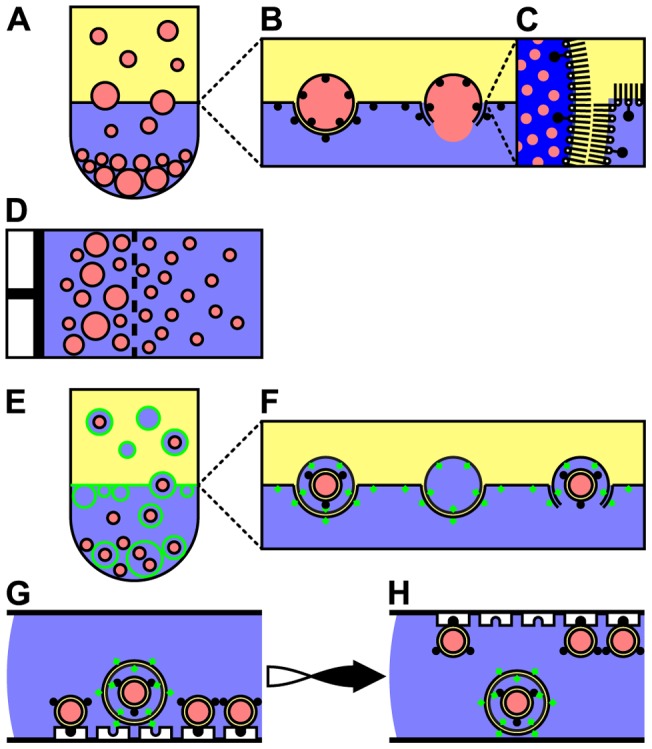
Schematic illustration of the preparation and isolation of intact hierarchical unilamellar vesicles (HUVs).A–C) Preparation of intermediate giant unilamellar vesicles (GUVs) employing the water-in-oil (w/o) emulsion transfer method. Black solid circles indicate biotinylated phospholipids. B, right) Imperfections in either of the two monolayers induce a release of the internal cargo into the hosting solution. C) When passing the water-oil interface the two phospholipid monolayers combine and form a bilayer confining the fluorescently active internal cargo (red circles). D) Repeated extrusion to homogenize the size distribution of the intermediate GUVs. E,F) Preparation of HUVs employing the vesicle-in-water-in-oil emulsion (v/w/o) transfer method. Green solid diamonds indicate fluorescently labeled phospholipids. G, H) Isolation of HUVs from released GUVs using a specially prepared isolation chamber. For details see text.